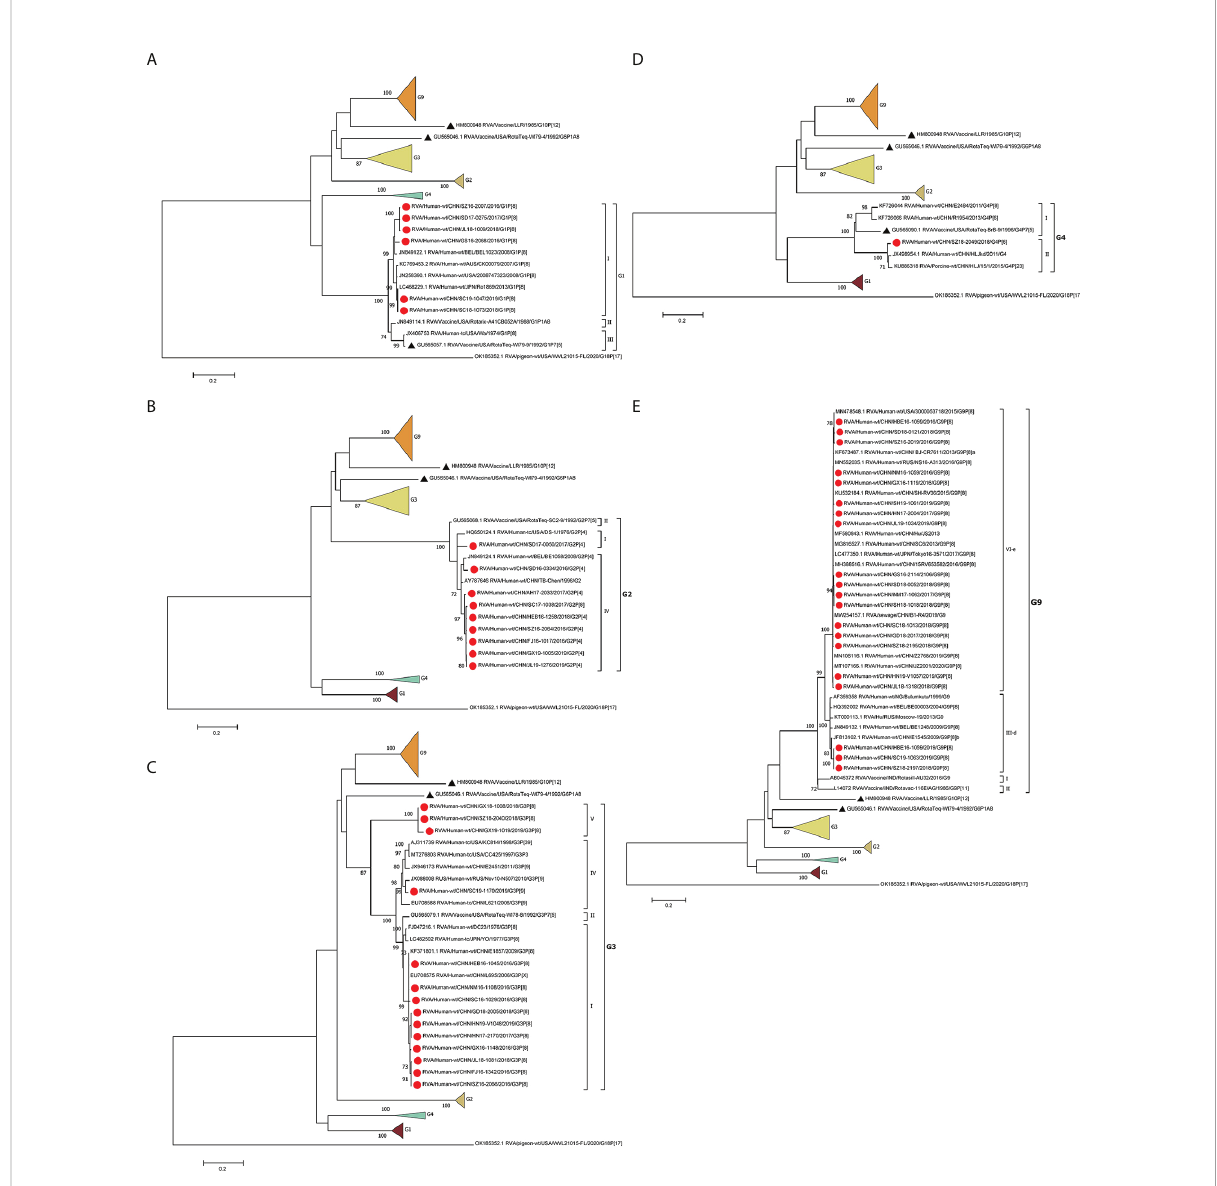
FIGURE 1 Phylogenetic analysis of the VP7 proteins of representative RVA strains and vaccine strains (RotaTeq G1 – 4, G6, Rotarix G1, LLR, Rotasill G9, and Rotavac G9). Maximum-likelihood (A – E) trees were constructed based on the complete VP7 CDS region gene sequences (978 base pairs). A GTR+G+I nucleotide substitution model was used to construct the phylogenetic tree. The pigeon RVA strain WVL21015-FL was used as the outgroup. Chinese strains are marked by red dots and vaccine strains by black triangles. Bootstrap values (1,000 replicates) of 70% are